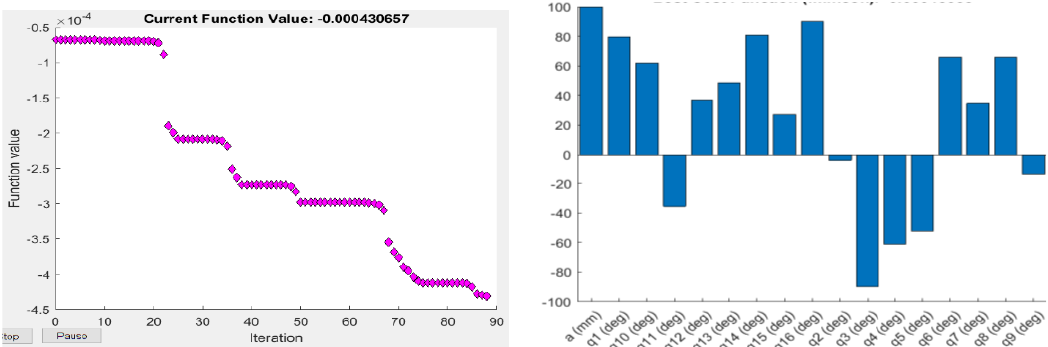
Figure 7. Objective function values ( left ), and the corresponding optimised joint parameters ( right ) for the best objective function value obtained by Fmincon for the ∆H manipulability measure.